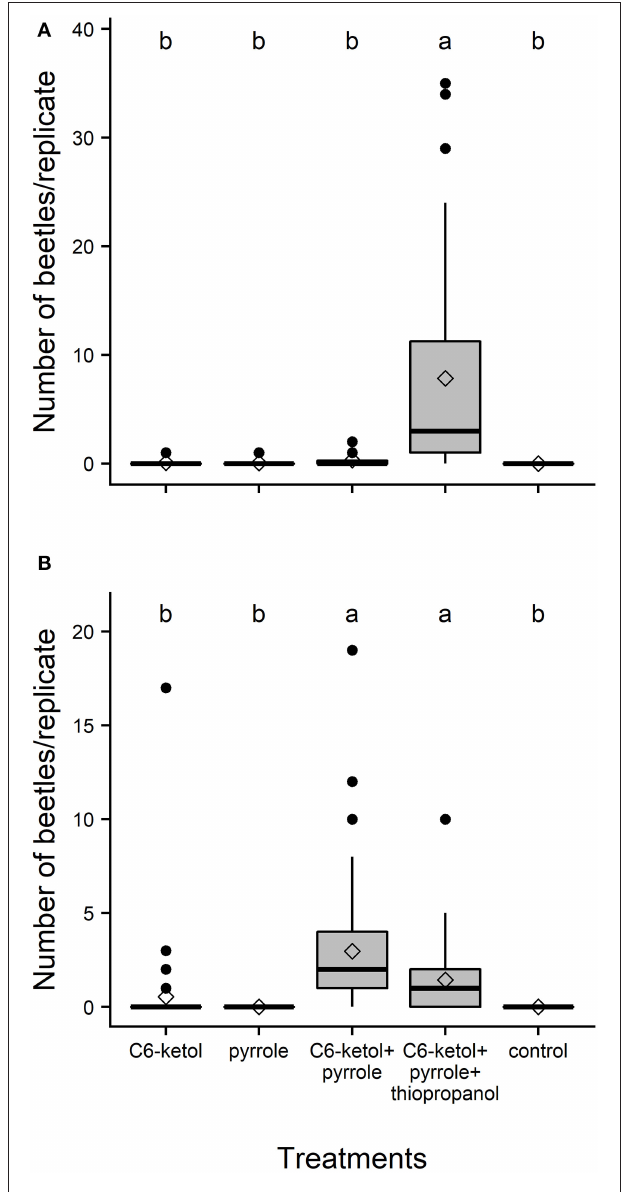
FIGURE 2 | Box-and-whisker plots of numbers of adult Ambonus distinctus (A) and Ambonus electus (B) that were caught per replicate in field bioassays of potential pheromones produced by conspecific males. Boxes show the upper (75%) and the lower (25%) percentiles of the data. The horizontal line and diamond within a box represent the median and mean, respectively. Whiskers indicate the highest and lowest values respectively, and dots indicate outliers. C6-ketol = racemic 3-hydroxyhexan-2-one; pyrrole = 1-(1 H -pyrrol-2-yl)-1,2-propanedione; thiopropanol = 3-methylthiopropan-1-ol. Means significantly different: Friedman’s Q (4,160) = 105.9, P < 0.001 ( N = 32), and Q 4,280 = 142.2, P < 0.001 ( N = 52), respectively. Means with different letters are significantly different (Dunn-Nemenyi multiple comparison test, P <